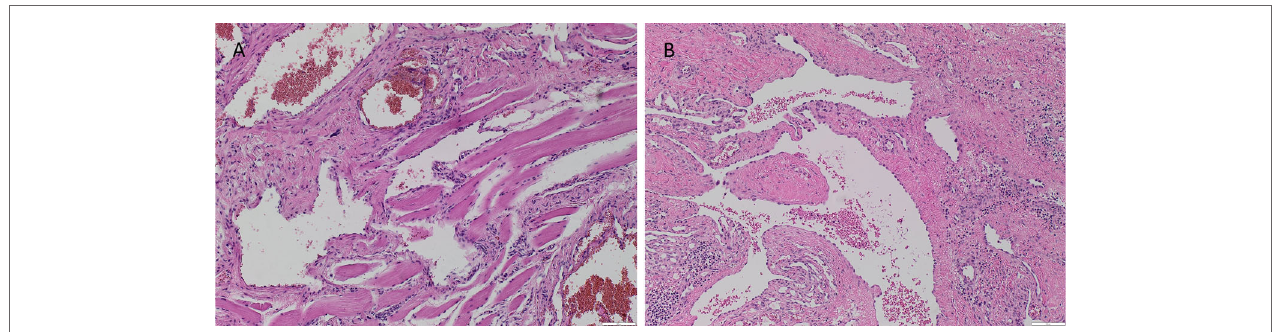
FigUre 1 | representative h&e stained slides of iM (a) and sc (B) VM showing thin-walled ectatic lesional vessels with variable density of smooth muscle cells . Original magnification: 100 ×